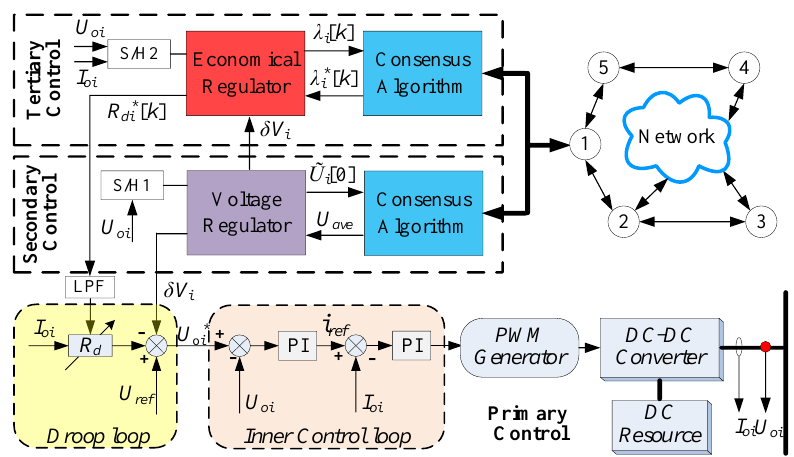
Figure 1. Hierarchical distributed control for the converters.